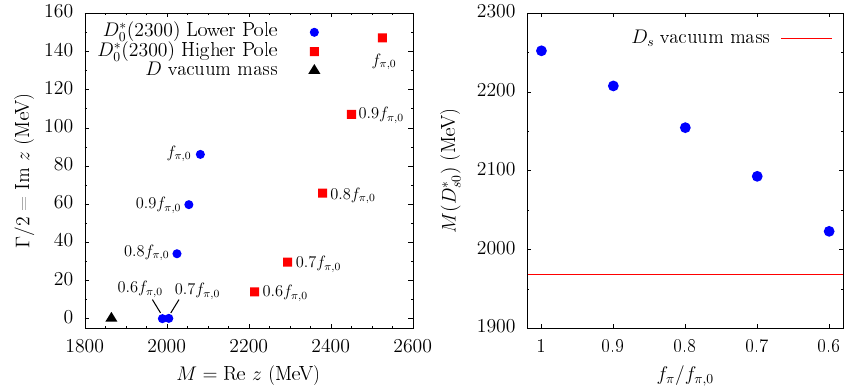
Figure 6: Pole positions of the meson charm states as functions of f π , when it is reduced with respect to its vacuum value. Left: ( J , S ) = ( 0,0 ) channel where the ( 2300 ) is generated. Right: ( J , S ) = ( 0,1 ) sector where “two-pole structure” of the D ∗ 0 ( 2317 ) the bound state D ∗ s 0